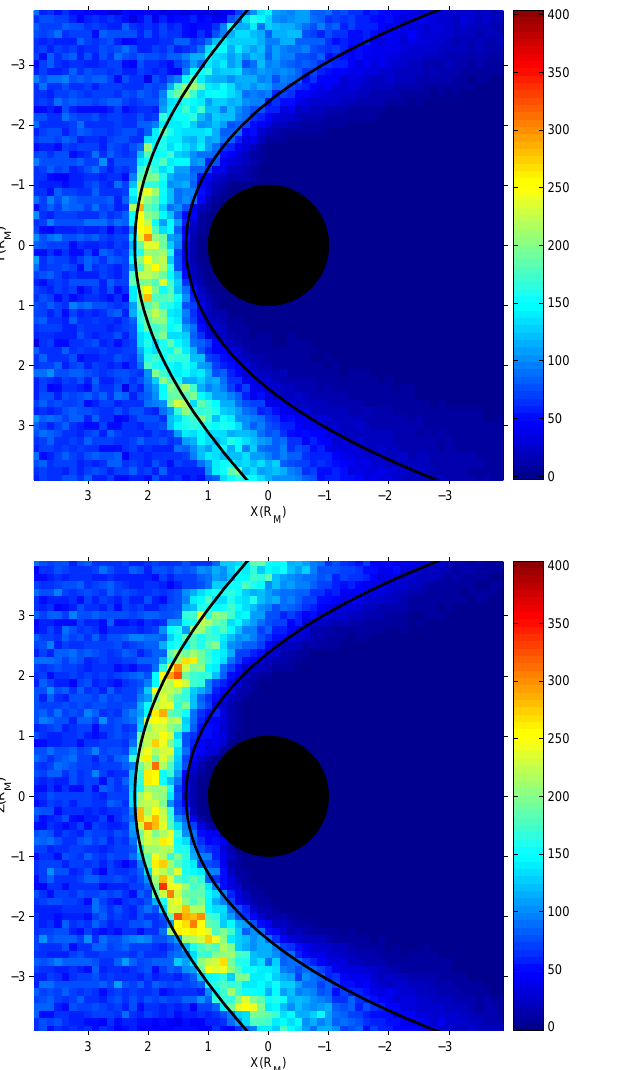
Fig. 3. The density of the solar wind protons in the hybrid model on ( a : top) the XY plane and on ( b : bottom) the XZ plane in a unit of cm − 3 . The black solid line closer and further the planet give an approximate position and shape of the resulted magnetopause and bowshock, respectively. See text for details.